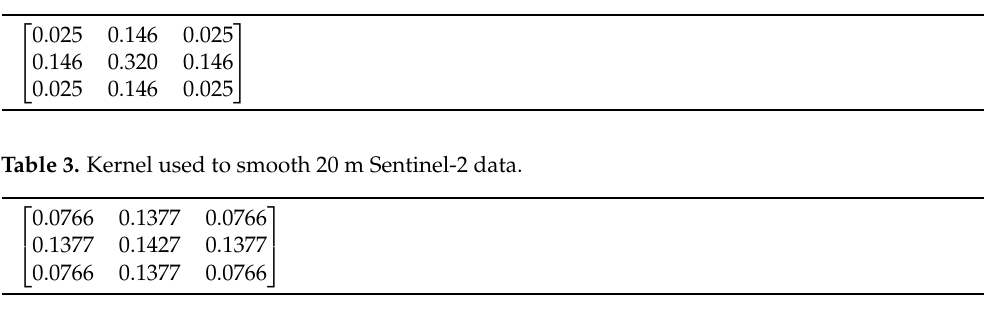
Figure 2. A schematic of the area of adjacent 20 m pixels within a 30 m radius circle factored into the weighting of the kernel used to smooth Sentinel-2 data. Table 2. Kernel used to smooth 30 m Landsat data.